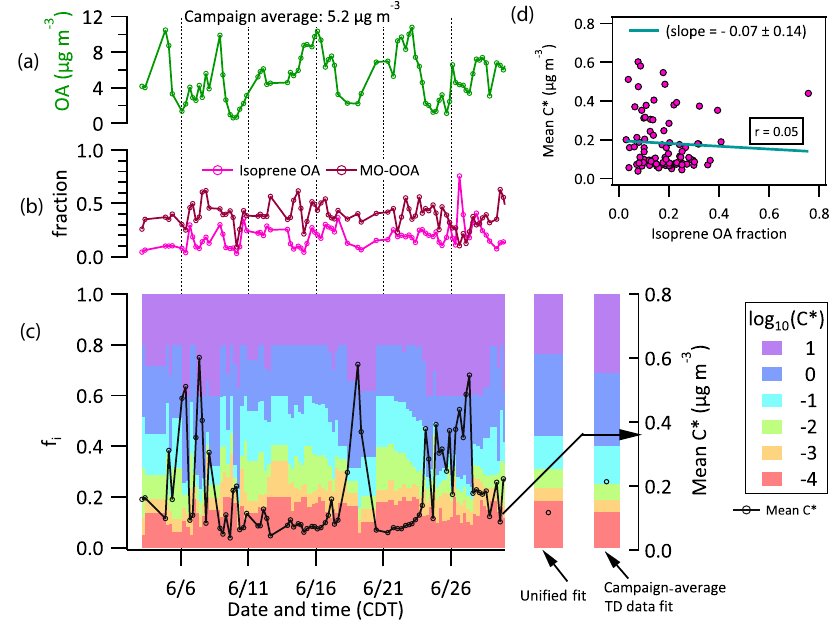
Figure 6. Time series of (a) ambient organic aerosol concentrations, C OA ; (b) fractional contribution of isoprene OA and more-oxidized oxygenated OA (MO-OOA) to total OA determined from PMF analysis; and (c) OA volatility distribution ( f i ) and mean C ∗ (open black circles) during the Centreville campaign. All data are averaged over ∼ 6h (the time resolution of f i distribution). Panel (d) shows a scatter plot of mean C ∗ versus isoprene-OA fraction in C OA . Figure S10 shows similar analysis results for the Raleigh